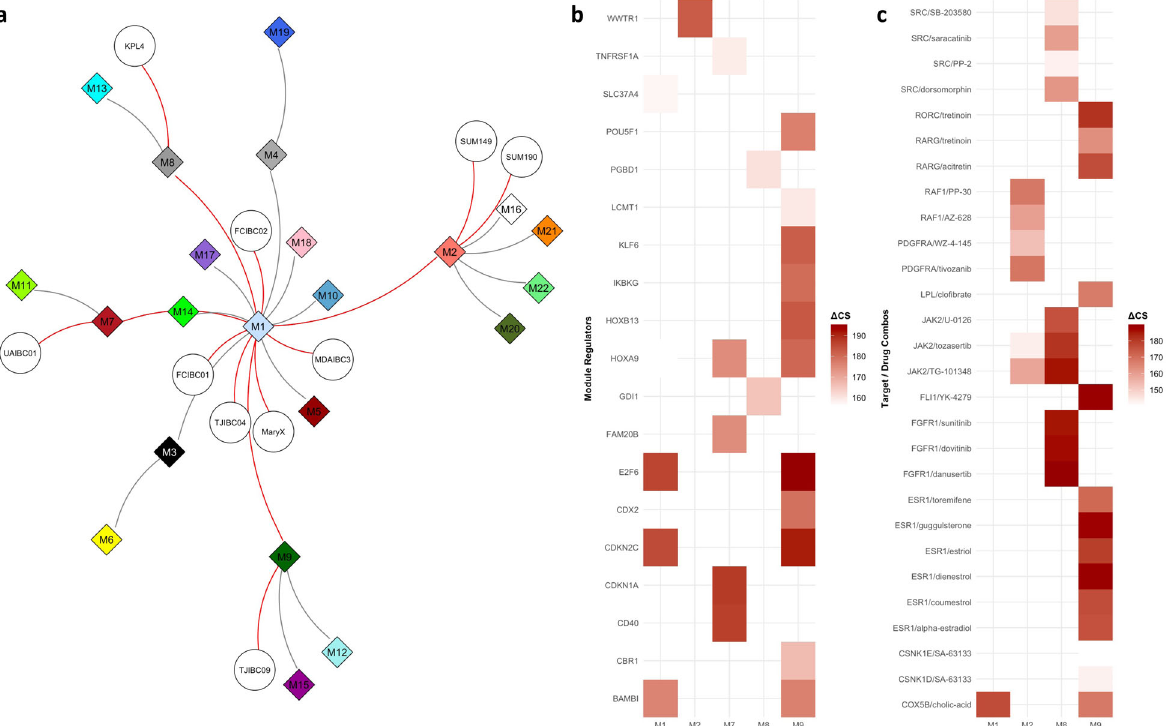
Fig. 3 Identi fi cation of co-expression cluster regulators and antagonizing chemical compounds. a Network diagram showing the minimal set of edges that connect all co-expression modules and cell lines and that were identi fi ed using a minimal spanning tree analysis performed on the binary adjacency matrix representing the full set of interactions between all modules and all cell lines. Co-expression modules and cell lines are indicated respectively as diamonds labeled by module number (i.e., M1 to M22) and circles labeled by cell line name. The edges connecting all cell lines through a minimal set of co-expression modules are indicated in red. b Results identifying upstream regulators (Y-axis) for each of the fi ve co-expression modules that connect all IBC cell lines (X-axis) are shown in heatmap format. At the intersection between rows and columns, cells are color-coded as shown in the legend only when the difference between the co-expression module speci fi c connectivity Scores (CSs) for overexpression and knockdown of the respective genes exceeds 150 (i.e., at least 75 upon overexpression and at most -75 upon knockdown). c Results identifying target/drug combinations (Y-axis) for each of the fi ve co-expression modules that connect all IBC cell lines (X-axis) are shown in heatmap format. At the intersection between rows and columns, cells are color-coded as shown in the legend only when the difference between the co-expression module speci fi c CSs for overexpression of the drug target and drug treatment exceeds 150 (i.e., at least 75 upon overexpression of the target and at most − 75 upon Fig. 5a. This reveals that expression levels MAX (i.e., the primary interaction partner of MYC; P = 0.099) and MLX (i.e., MAX-like protein, another dimerization partner of MYC; P = 0.053) were positively correlated with MYC, whereas a negative correlation was reported for MXD3 (i.e., MYC competitive MAX dimerization partner; P = 0.001). These relationships were recapitulated in a series of 146 samples from patients with IBC (i.e., correlation P values for MAX: P = 0.005, MLX: P < 0.001 and MXD3: P = 0.027; Fig. 5b). In addition, an inverse relation between MYC and MYCN (i.e., another member of the family of MYC transcription factors)